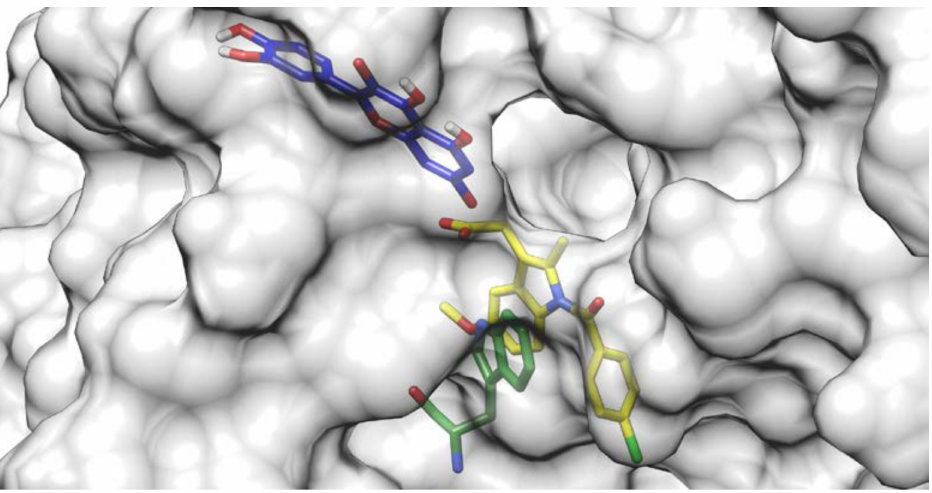
Figure 4. Quercetin anion at Position 7 (blue) docked to a crystallographic structure of indomethacin (yellow) bound to HSA. The Trp214 residue is depicted in green.